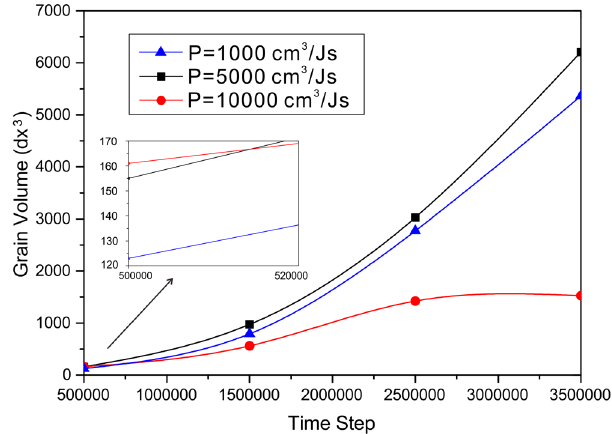
Figure 9. Average volume of the grains corresponding to different